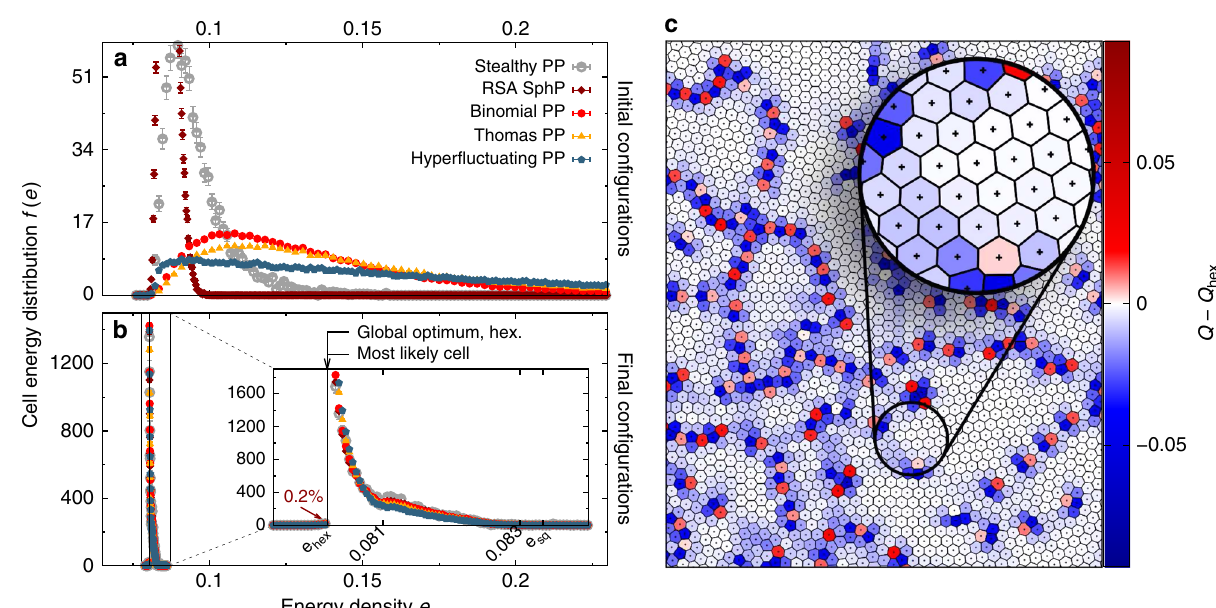
Fig. 4 Effectively hyperuniform and universal fi nal con fi gurations in 2D with local crystallites. Frequency distribution f ( e ) of cell energy densities e (see Methods section) are shown before ( a ) and after ( b ) application of 10 4 iterations of Lloyd ’ s algorithm (see Methods section for initial point processes). The error bars represent the standard error of the mean. In the fi nal con fi gurations, which are effectively universal, only a small portion of cells (0.2%) has an energy density lower than that of the (globally optimal) regular hexagon. Here e sq is the energy density of the square lattice. c Voronoi cells in the fi nal CVT: The colour code indicates the difference between the isoperimetric ratio Q = 4 π A / P 2 of each cell, where A is the area and P the perimeter of the cell, and the isoperimetric ratio Q hex = 0.9069 of the regular hexagon. The local crystallites and their globally amorphous arrangement are clearly visible. For the structure factor of the initial and fi nal con fi gurations, see Supplementary Fig.